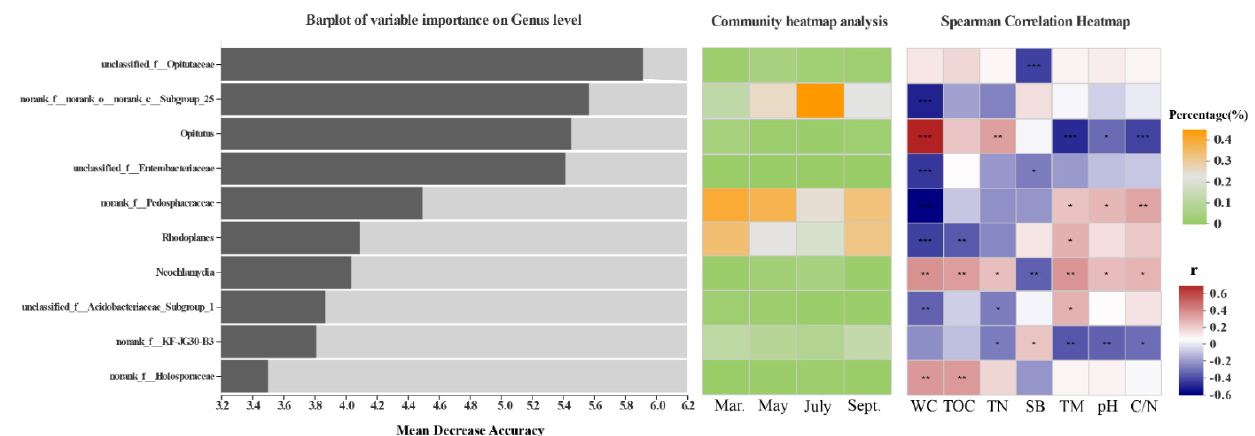
Figure 6. Top 10 identity biomarkers used for discriminating bacterial communities in different seasons (detected by random forest model). The assigned taxonomy of each taxon is displayed at the genus level. The bar plots on the left show the importance value of each biomarker estimated by the random forest model; the middle heatmap plots show the relative percentage of those biomarkers in different seasons; the right heatmaps show the Spearman correlations between the relative abundances of identity biomarkers and environmental variables. WC, soil water content; TOC, total organic carbon; TN, total nitrogen; SB, shoot biomass; TM, soil temperature; *** p < 0.001; ** p < 0.01; * p < 0.05.